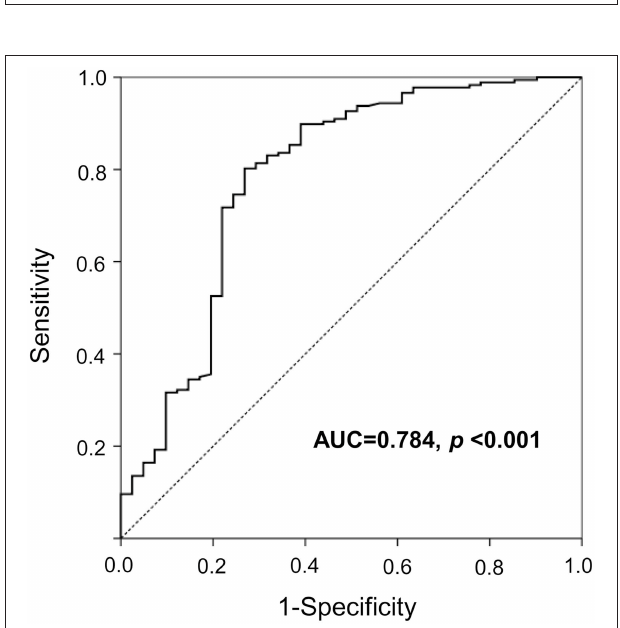
FIGURE 2 | A ROC curve with serum netrin concentrations for the prediction of IFG or type 2 diabetes. IFG, impaired fasting glucose; ROC, receiver operating